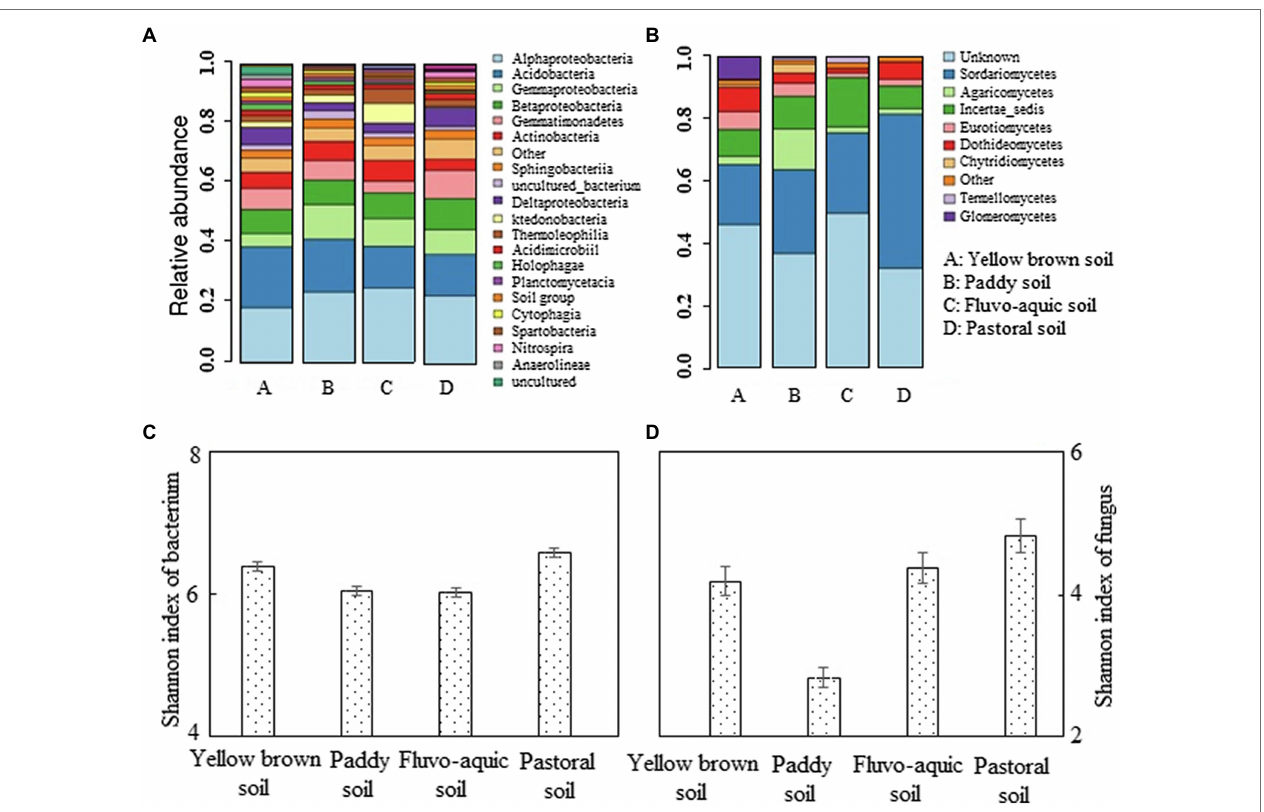
FIGURE 3 | Analysis of bacterial and fungal levels in different soils. (A,B) represented the abundance of bacterium and fungus, respectively. (C,D) represented the shannon index of bacterium and fungus,